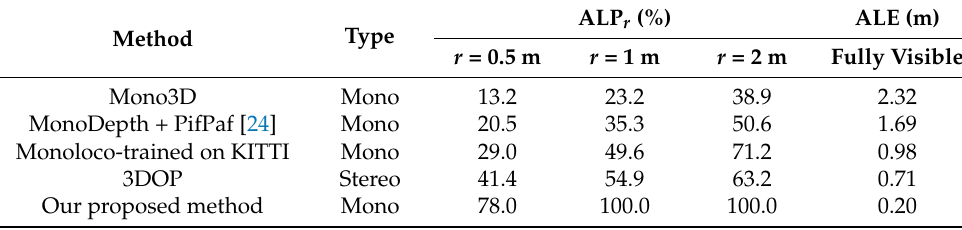
Table 5. Comparing our proposed method against baseline results on the KITTI